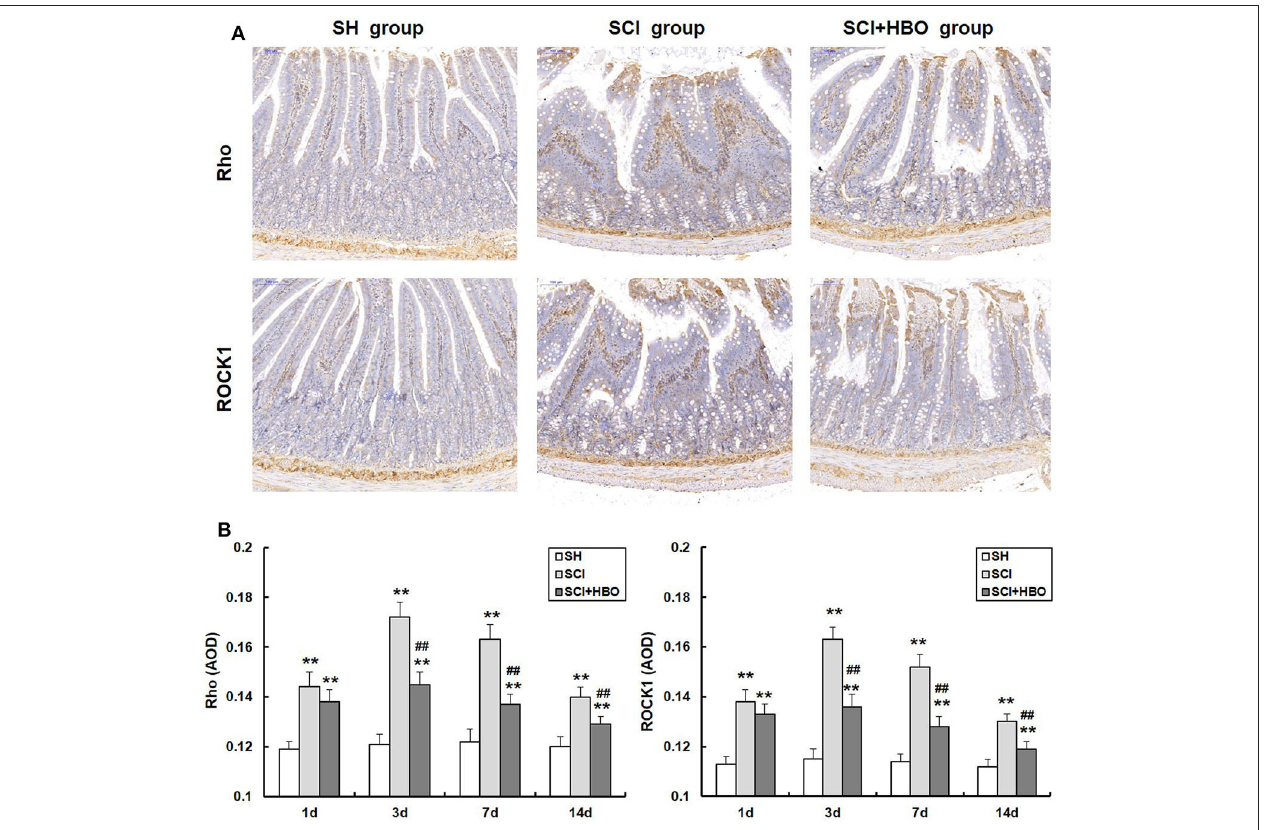
FIGURE 5 | Effect of HBO on Rho and ROCK1 immunoreactivity in jejunum tissue after SCI. (A) Expressions of Rho and ROCK1 in the jejunum tissue visualized by immunohistochemistry under a high magnification on postoperative day 3 (all images are × 200 magnification, bar = 100 µ m). (B) Analysis of the average optical density of Rho and ROCK1. Data are presented as mean ± SD. Compared with the SH group, the average optical density of two factors significantly increased after SCI (** P < 0.01); HBO exposure significantly decreased the average optical density of Rho and ROCK1 compared with the SCI group ( ## P < 0.01). HBO, hyperbaric oxygen; SCI, spinal cord